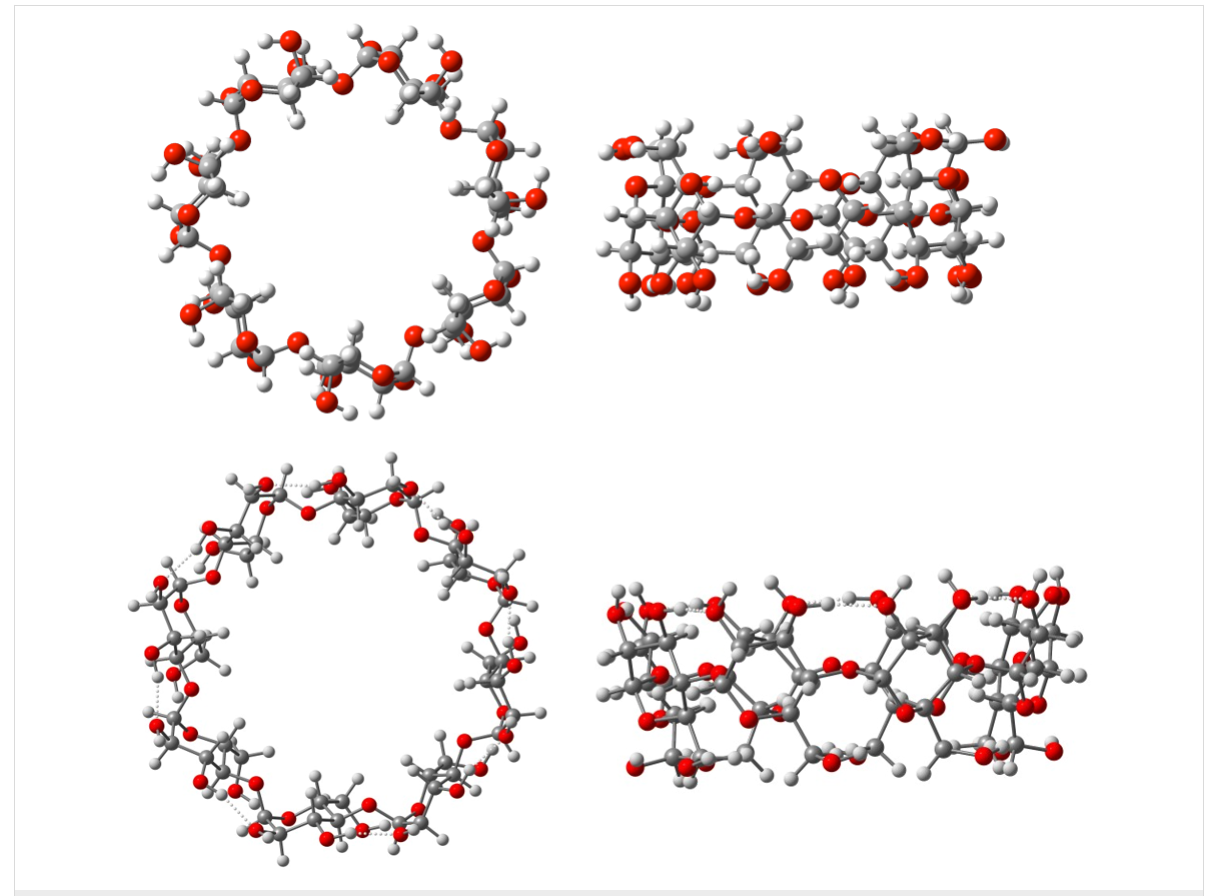
Figure 10: Optimised geometry for β -CD (top) and γ -CD (bottom), viewed from above (left) and from the side (right).